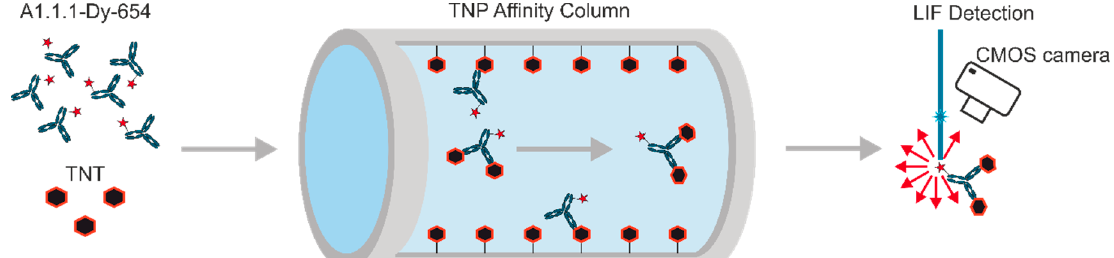
Figure 1. A biosensor based on an immunofluorometric assay: The monoclonal antibody A1.1.1 against 2,4,6-trinitrotoluene (TNT) is labeled with the fluorescent dye Dy-654. This conjugate is briefly preincubated with the sample and pumped through the antigen-coated affinity column, which traps free antibody. Only antibody-TNT complexes reach the highly sensitive, laser-induced fluorescence (LIF) detector.